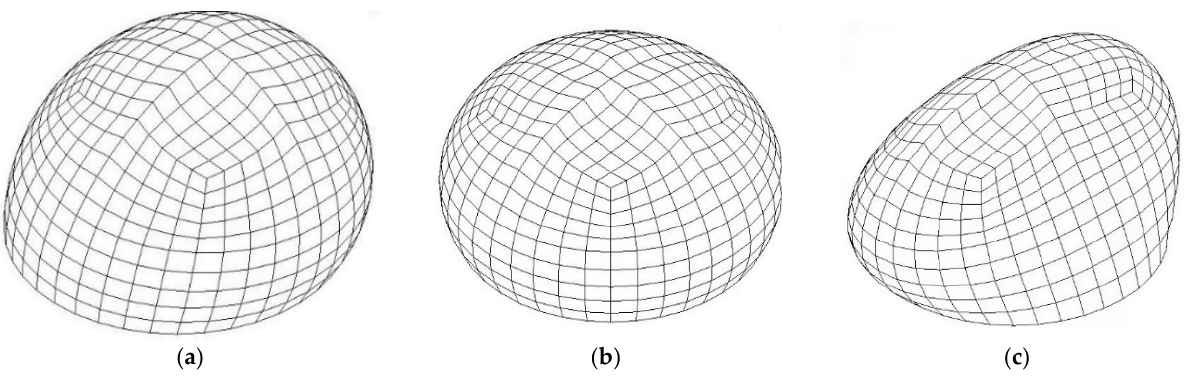
Figure 15. First 5 mode shapes of the model: ( a ) 1st and 2nd mode ( f 1 = f 2 = 2.4 Hz), ( b ) 3rd mode ( f 3 = 9.1 Hz), and ( c ) 4th and 5th mode ( f 4 = f 5 = 15.5 Hz).